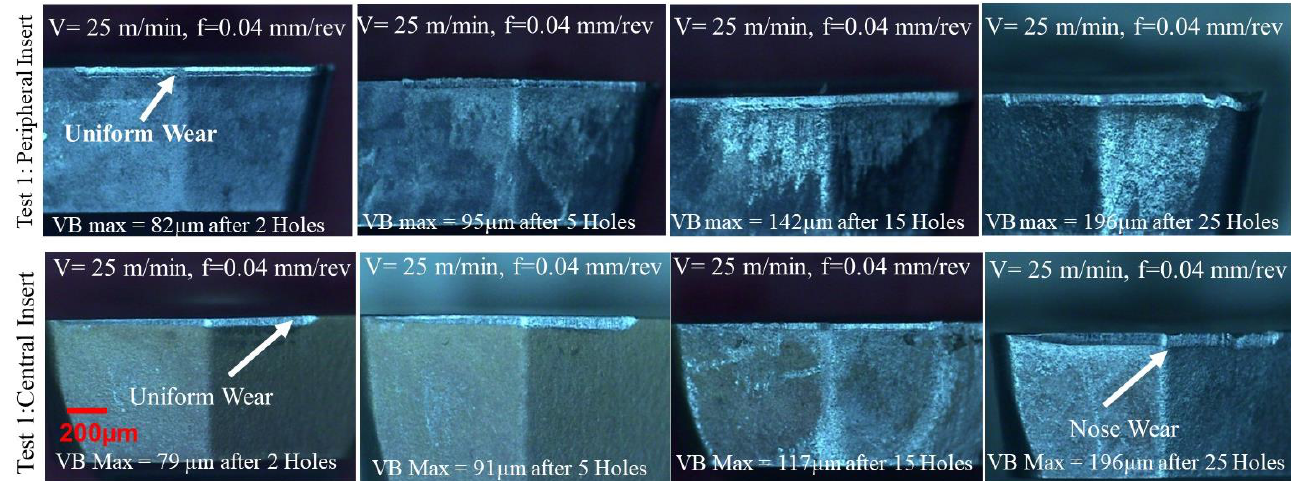
Figure 12. Wear evolution of central and wiper inserts in Test 1.